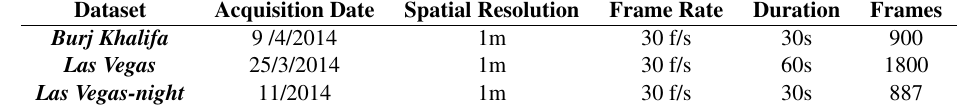
Table 1: The satellite video datasets that were employed for the validation of the developed registration framework.